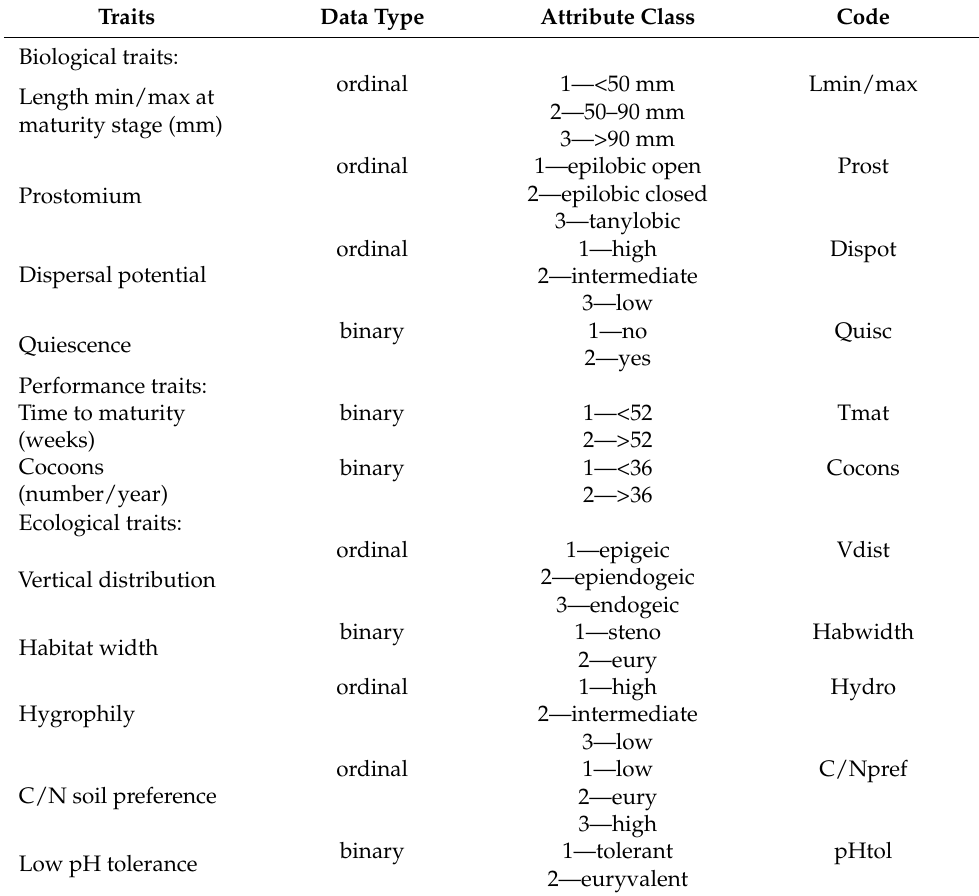
Table 2. Attribute classes, types of data and codes of earthworm functional